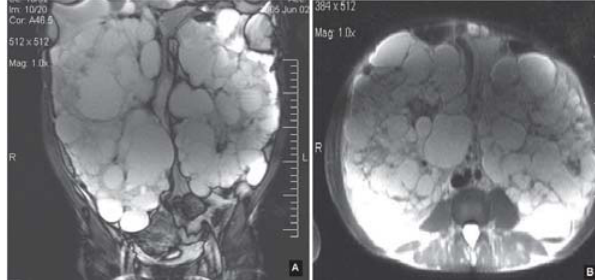
Figure 1 - MRI of large kidneys occupying almost the entire abdomen. A – coronal view; B – transversal view